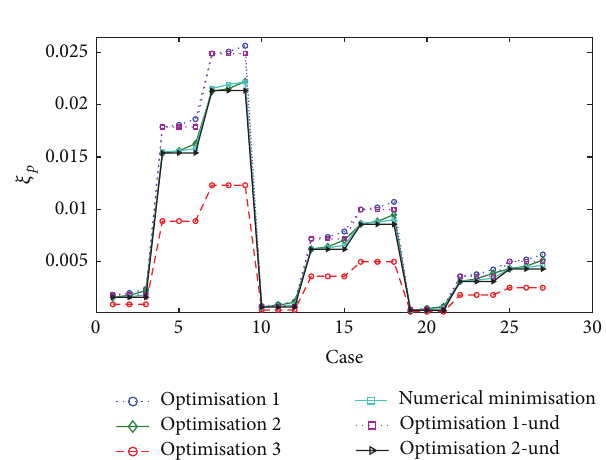
Figure 12: 𝜔 𝑝 values for the different optimisation methods consid- ered and for all the cases of Table 5.